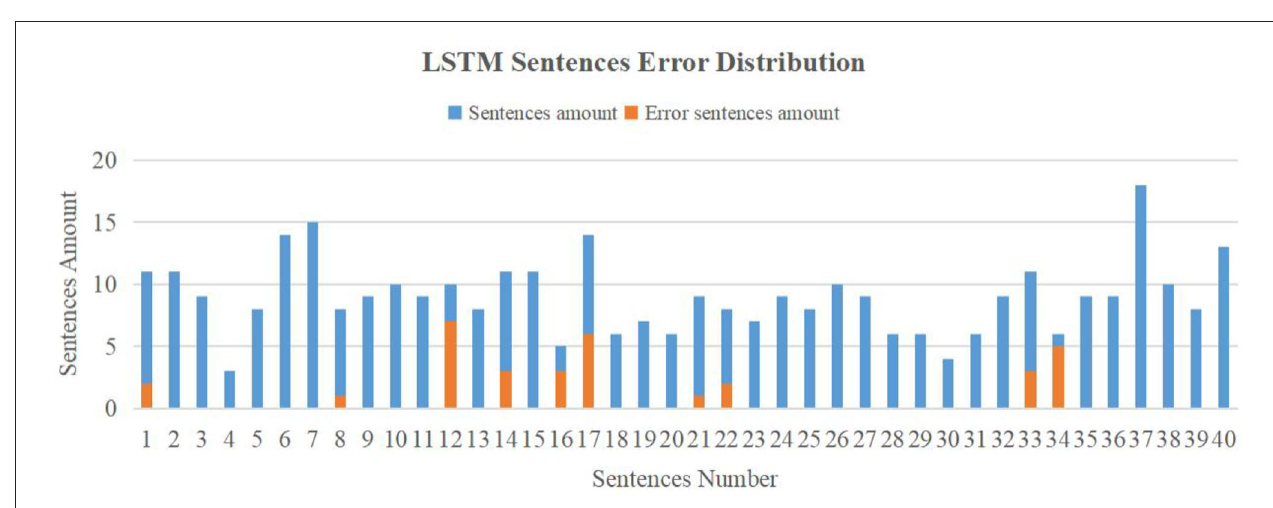
FIGURE 9 | Long short-term memory (LSTM) model evaluation